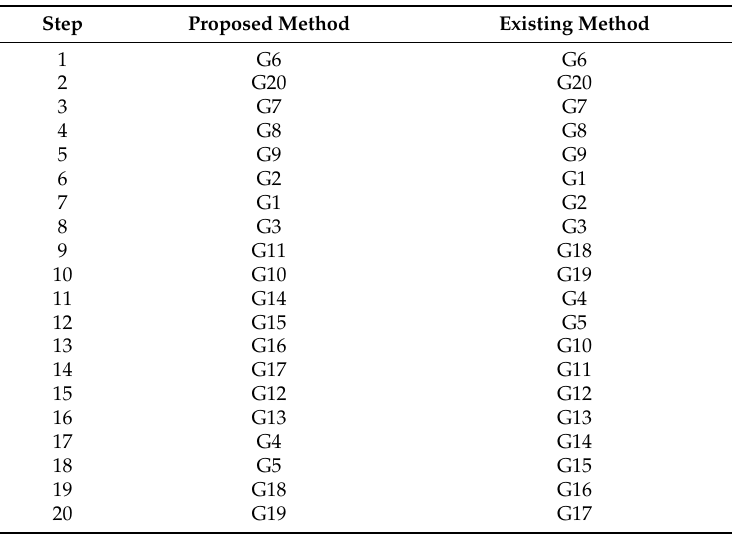
Table 4. Comparison of generator start-up